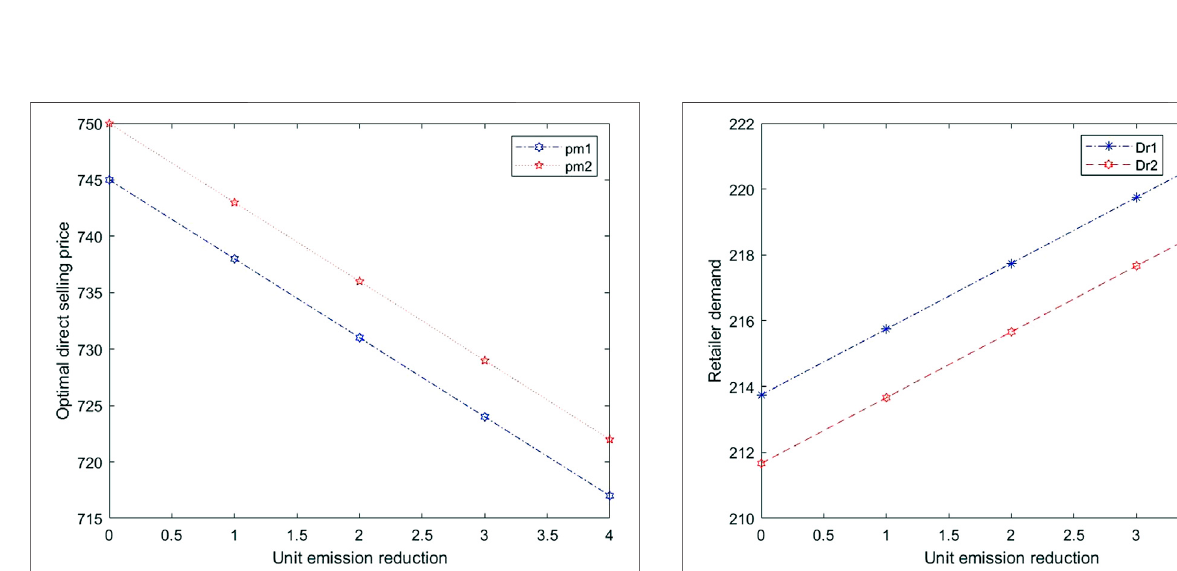
FIGURE 6 | Wholesale price comparison chart.